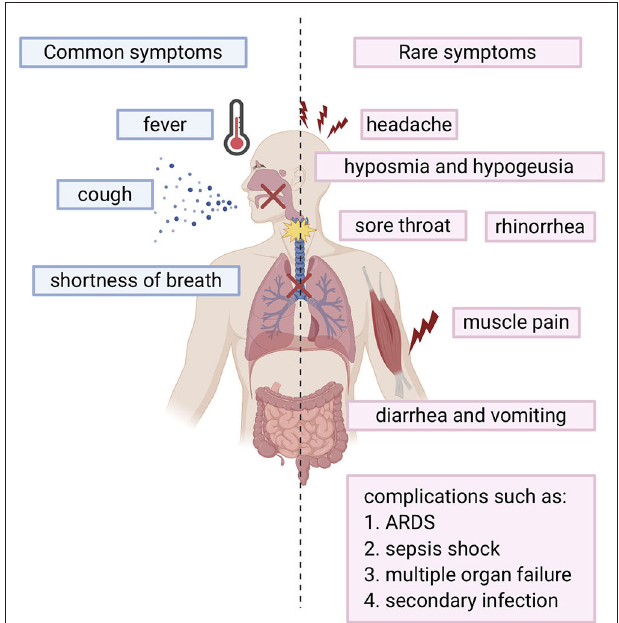
FIGURE 1 | Overview of COVID-19 symptoms: Blue bars represent the common symptoms. Pink bars represent the rare